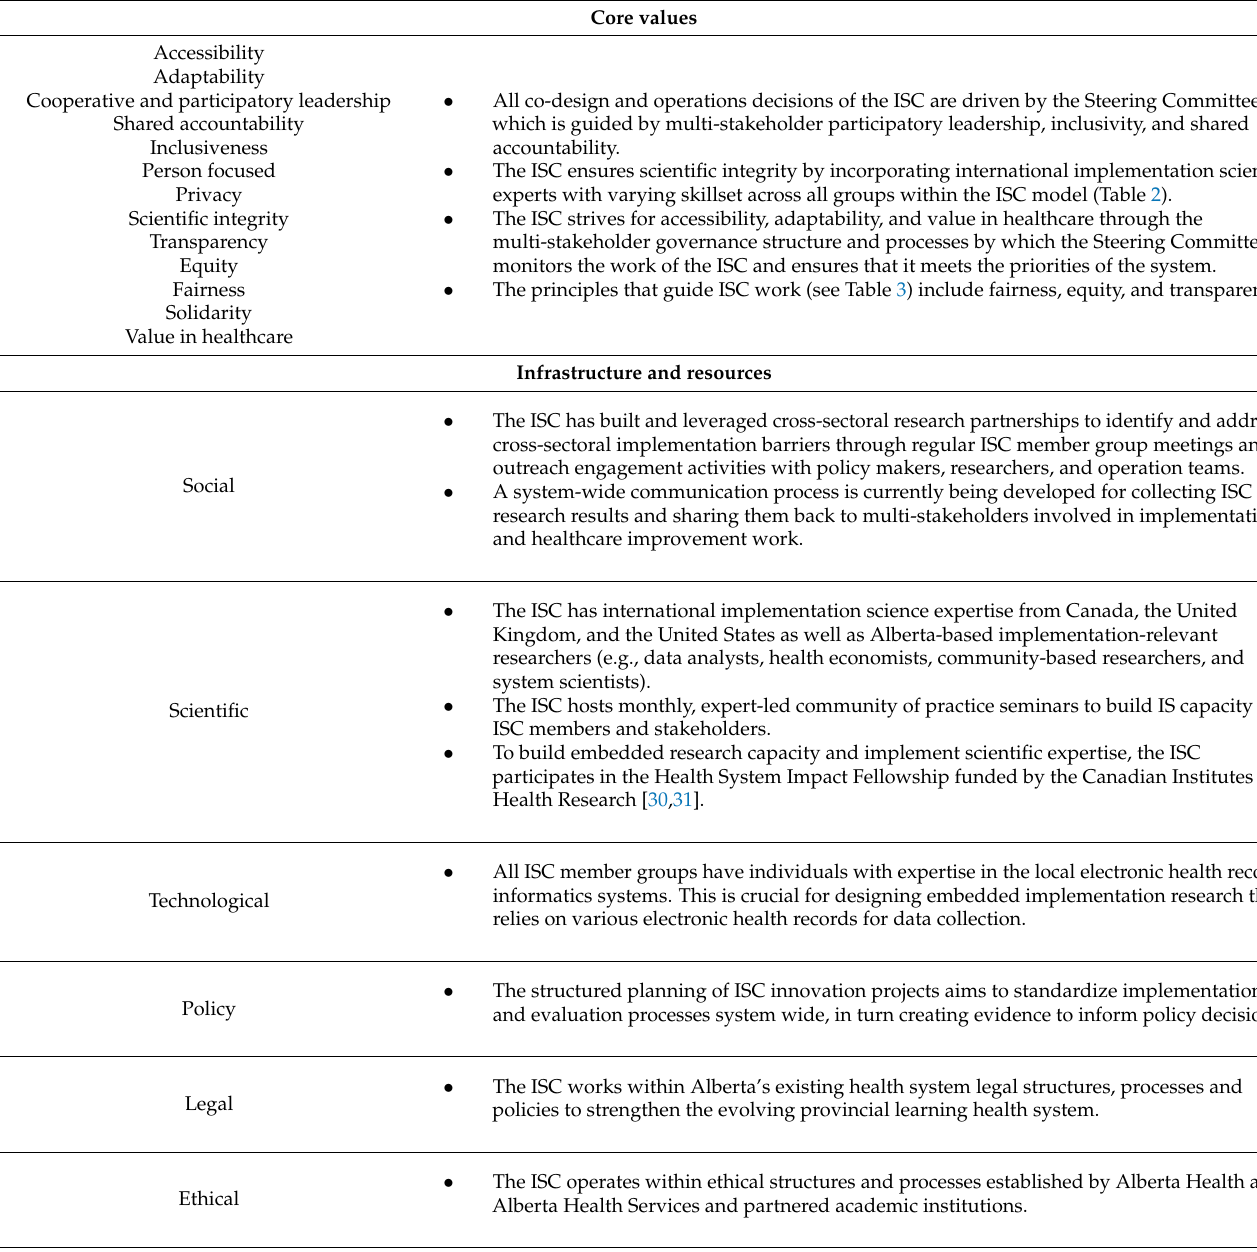
Table 1. Summary of comparative analysis of the ISC model to Menear’s conceptual framework. Menear’s